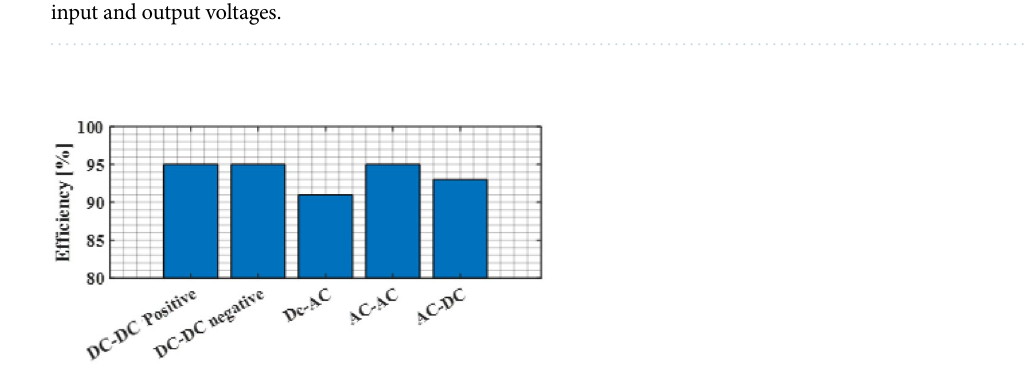
Figure 21. Efficiency of the proposed